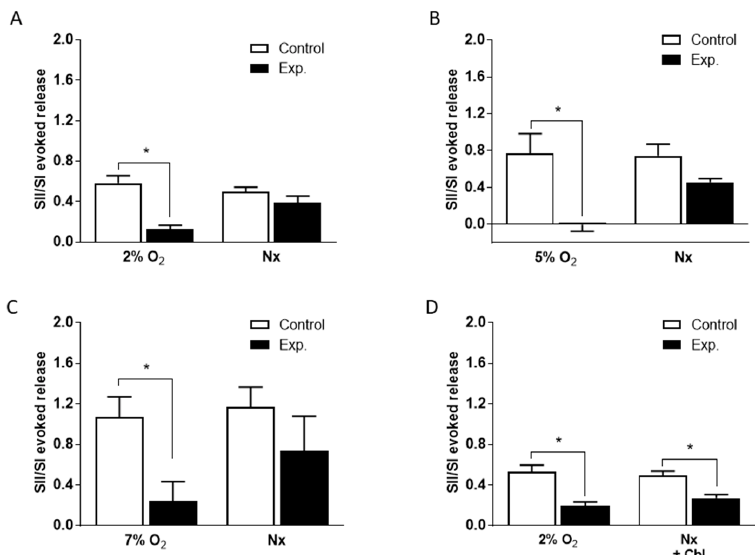
Antioxidants 2019 , 8 FOR PEER REVIEW